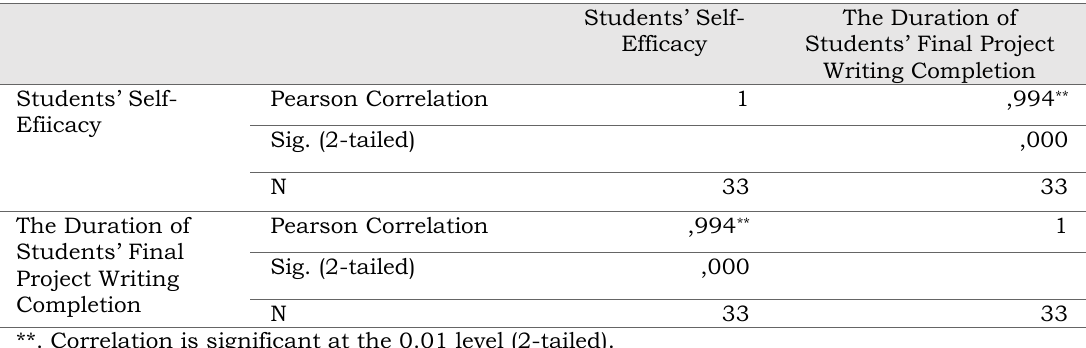
Table 6. Correlation between self-efficacy and the duration of students’ final project